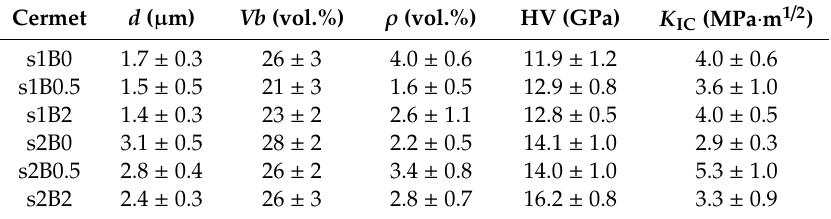
Table 2. Physical characteristics (volumetric porosity ( ρ ), average ceramic particle size ( d ), volumetric binder phase percentage ( Vb ), and mechanical properties (Vickers hardness (HV) and fracture toughness (K IC )) for both sets of (Ti,Ta)(C,N)-Co-B based cermets: s1B0 , s1B0.5 , s1B2 , s2B0 , s2B0.5 , and s2B2 . Cermet d ( µ m) Vb (vol.%) ρ